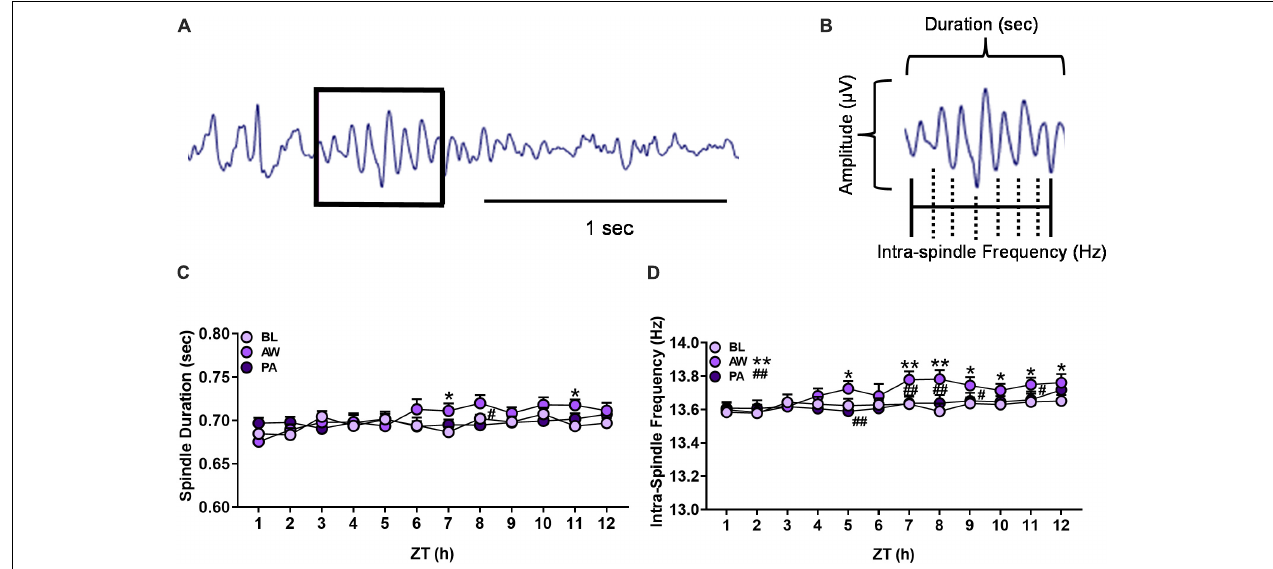
FIGURE 4 | (A) Representative EEG trace from NREM sleep containing an identified sleep spindle (boxed) using automated spindle detection. (B) Diagram of sleep spindle that is characterized as a waxing and waning sine wave: amplitude ( µ V), sleep spindle duration (seconds), and intra-spindle frequency (Hz) oscillation cycles. (C,D) Effects of alcohol withdrawal state [baseline (BL): light purple circles; acute withdrawal (AW): medium purple circles; and protracted abstinence (PA): dark purple circles] on (C) mean spindle duration (seconds; + SEM) and (D) mean intra-spindle frequency (Hz; + SEM) for each hour during NREM sleep for females and males combined. * p < 0.05, ** p < 0.01 vs. BL; # p < 0.05, ## p < 0.01 vs.